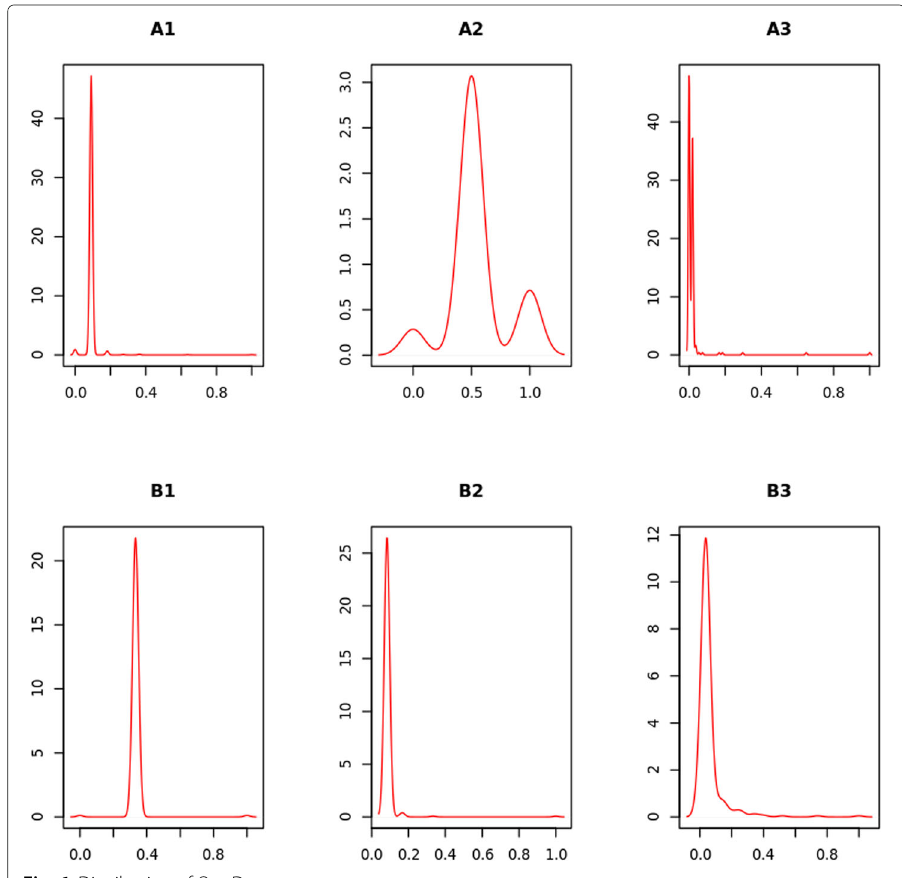
Fig. 6 Distribution of Out